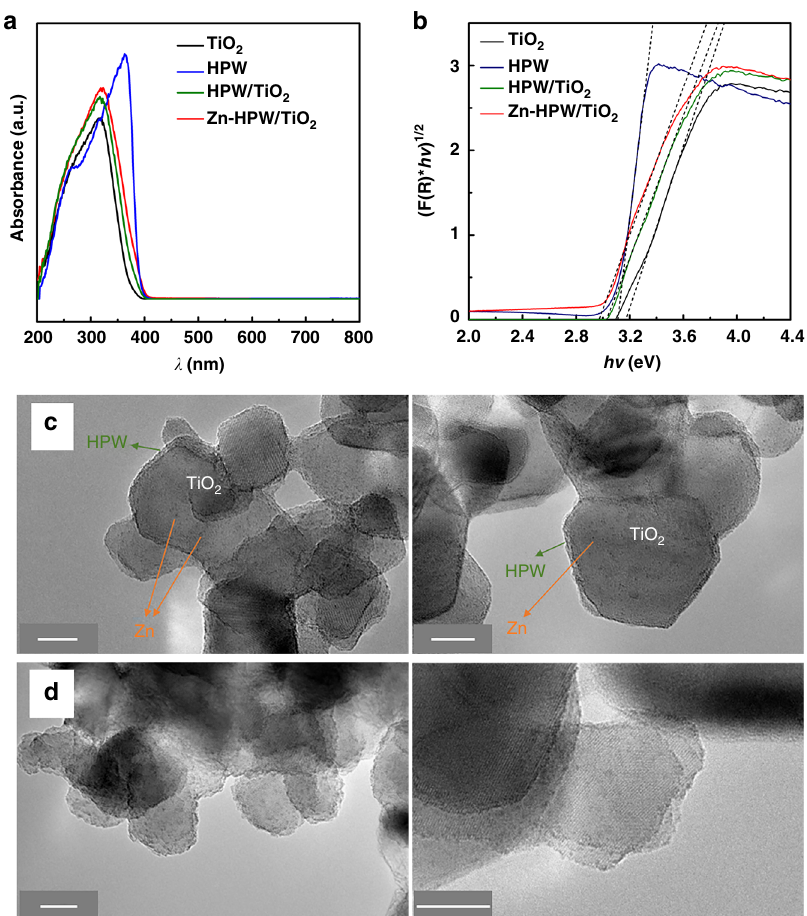
Fig. 3 UV-visible spectra and TEM images. a UV-Vis spectra and b [F(R ∞ ) h ν ] 1/2 versus h ν for Zn-HPW/TiO 2 and reference compounds; TEM images of calcined ( c ) and used ( d ) Zn-HPW/TiO 2 . Scale bar: 10